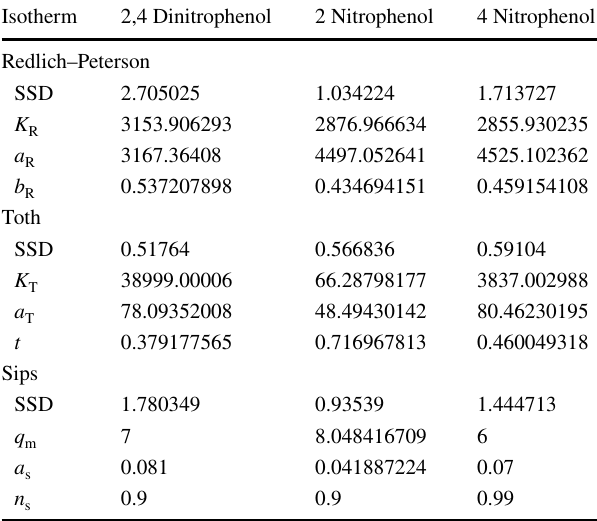
Table 4 Nonlinear adsorption parameters for the applied three- parameter adsorption